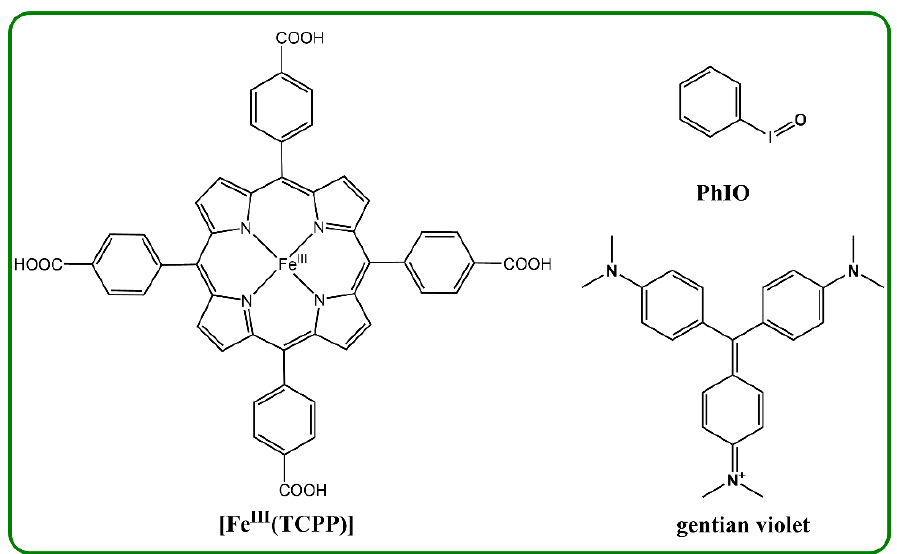
Figure 1. Structures of the catalyst [Fe III (TCPP)], the dye gentian violet and the oxidant iodosylben- zene (PhIO) used in this study.